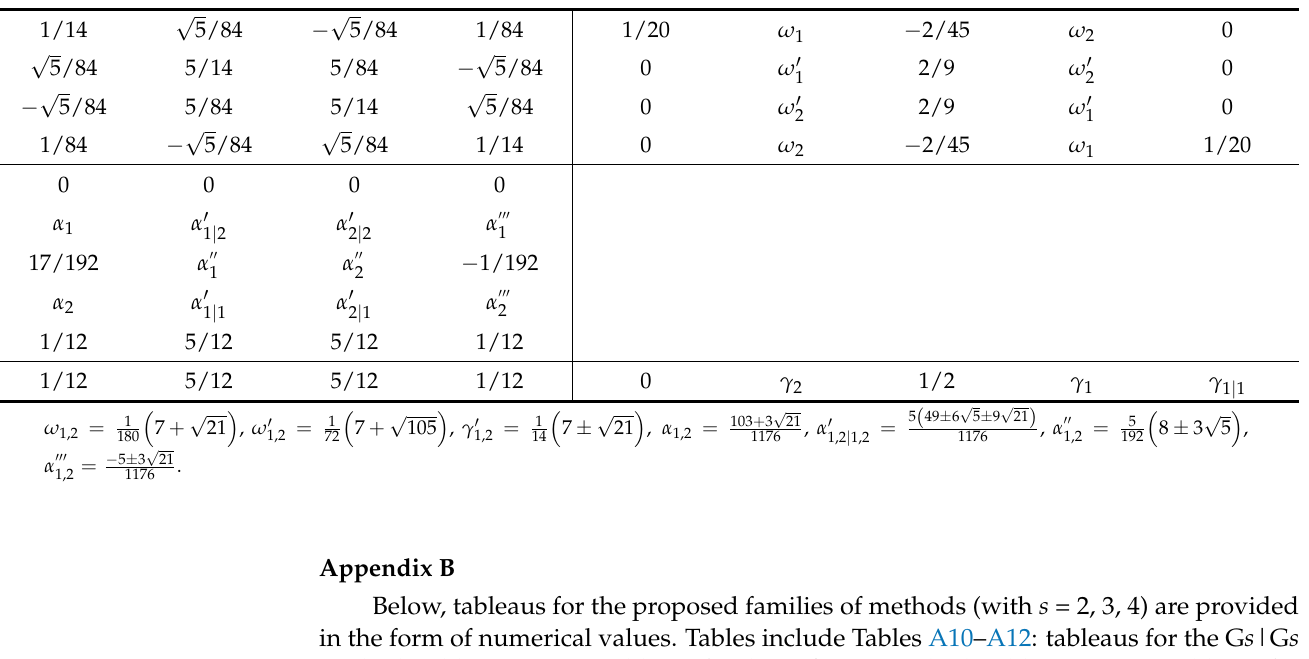
the L s |L s method, Tables A19–A21: tableaus for the L s |L s +1 method, Tables A22–A24: tableaus for the L s |G s +1 method, Tables A25–A27: tableaus for the eL s |G s method, and Tables A28–A30: tableaus for the eL s |G s +1